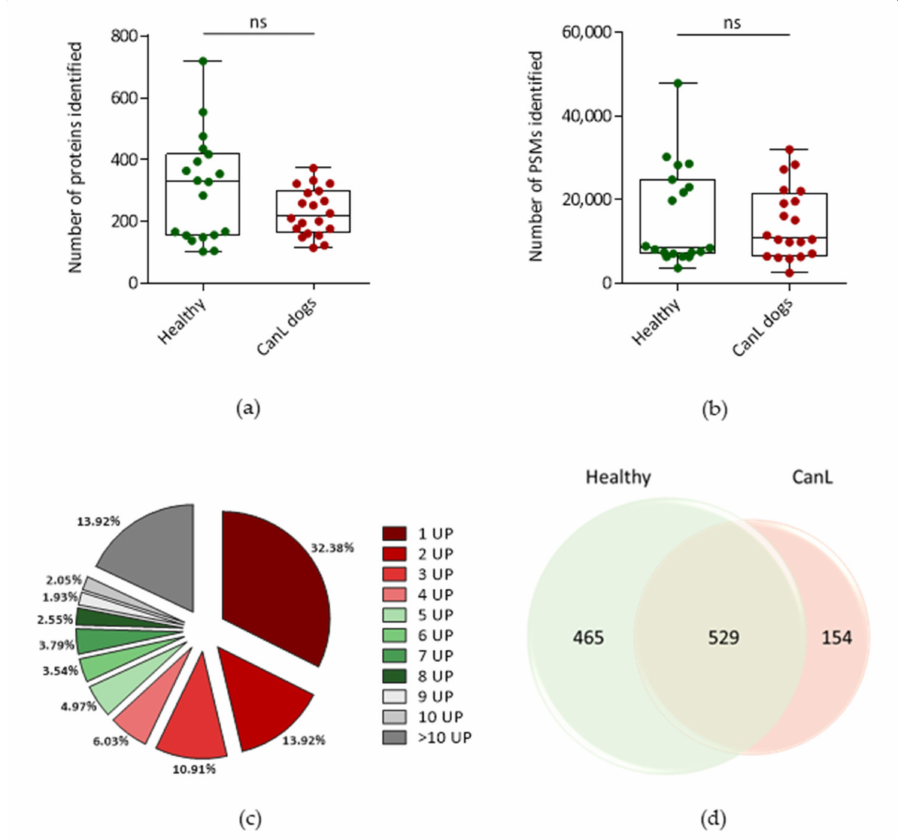
Figure 2. Number of ( a ) canine proteins and ( b ) spectrums—PSMs identified for each EVs sample in the healthy animals and in CanL animals. Statistical significance was accessed using Mann-Whitney test. ns—non-significant; ( c ) number of unique peptides associated with each protein identification. ( d ) Venn diagram of the number of proteins identified in the merge of CanL group versus Healthy group. Only proteins with 2 or more unique peptides and a maximum false discovery rate (FDR) of 1% for peptides were